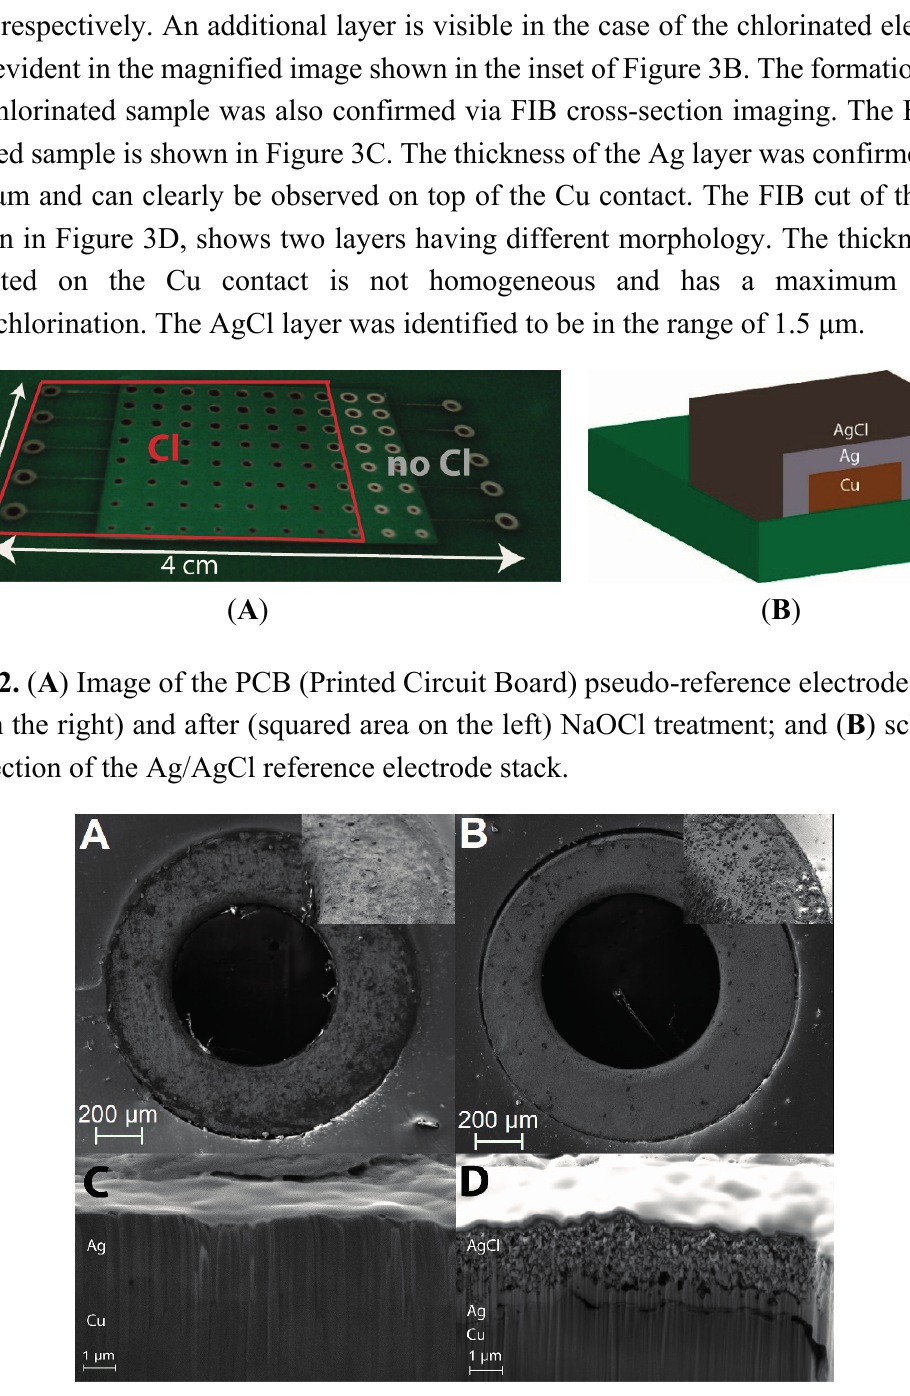
Figure 3. SEM images of the Ag-coated contacts ( A ) before and ( B ) after chlorination and FIB cross-sections of the Ag-coated contacts ( C ) before and ( D ) after chlorination. In order to evaluate the surface properties of both non-chlorinated and chlorinated Ag-coated Cu contacts, XPS spectra of non-chlorinated and chlorinated Ag-coated Cu contacts were collected